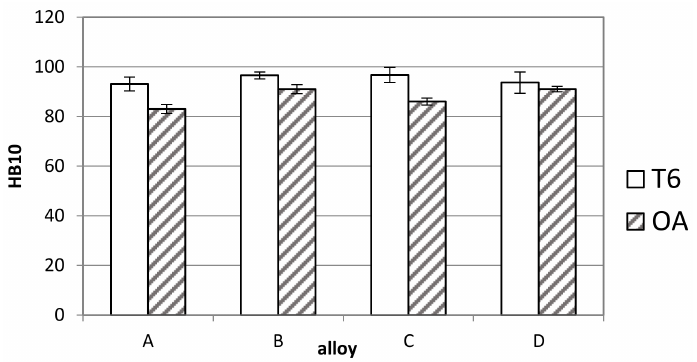
Figure 6. Brinell hardness (HB10 scale) measured on T6 and overaged (OA)